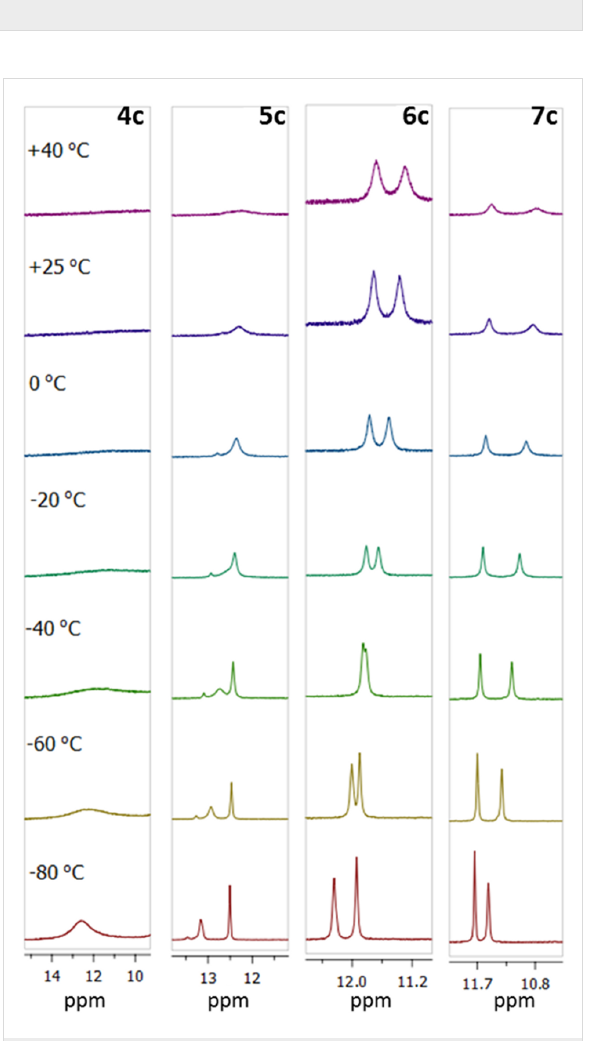
Figure 7: C=NH 2+ Signal regions of temperature-depending spectra for compounds 4c – 7c , acetone- d 6